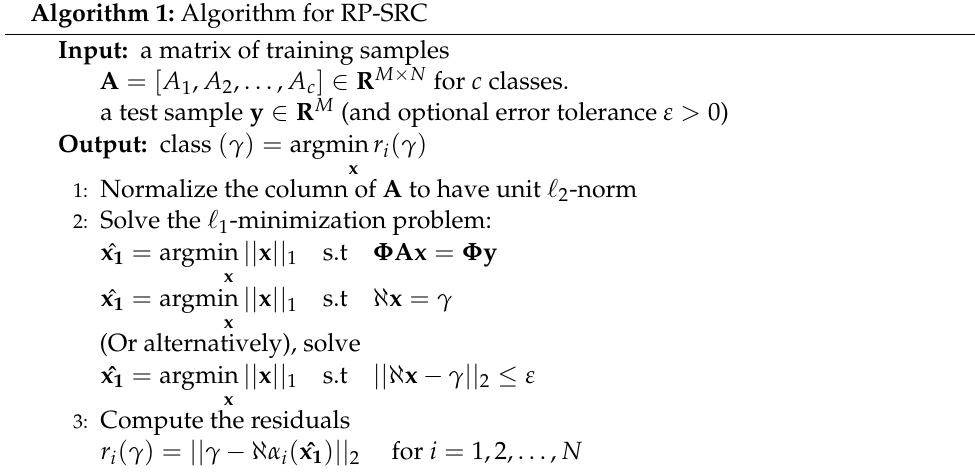
Figure 3. Underdetermined System After Dimensionality Reduction. The algorithm for dimensionality reduction using random projection on SRC method described on Algorithm 1. Algorithm 1: Algorithm for